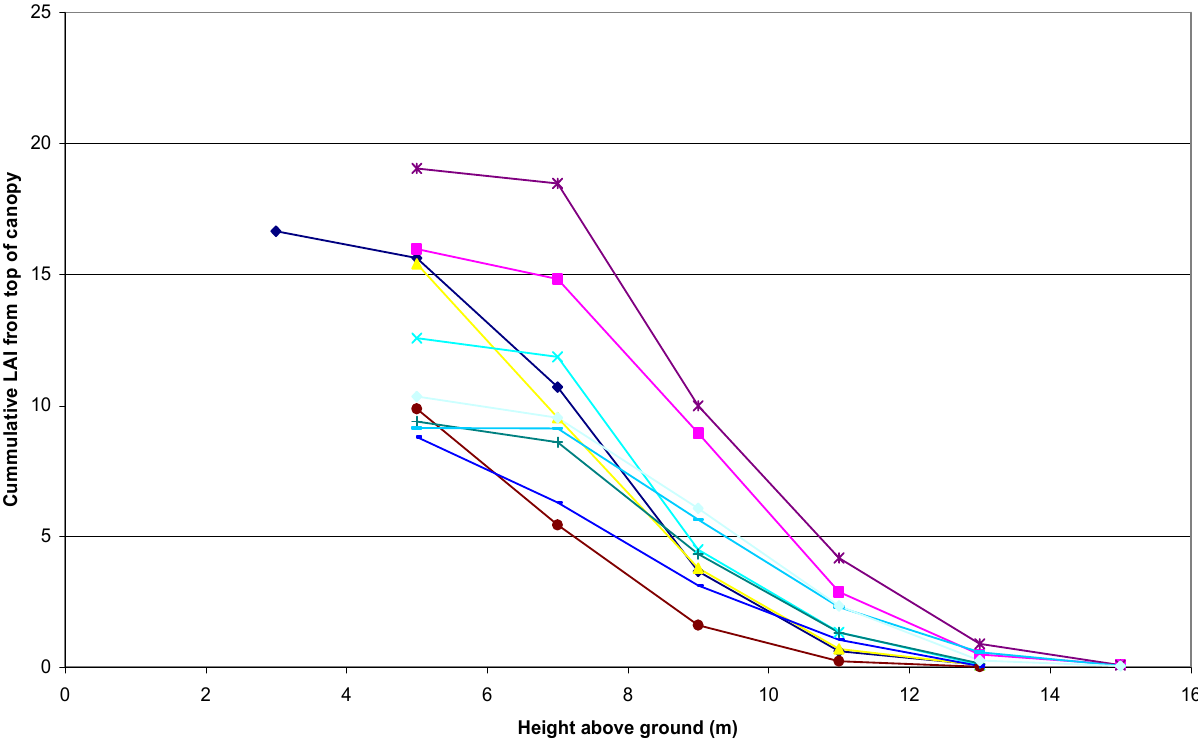
Figure 2. Cumulative leaf area index profiles for 10 radiata pine plots at Puruki, based on measurements by 2 m height zones above ground and summed from the top of the